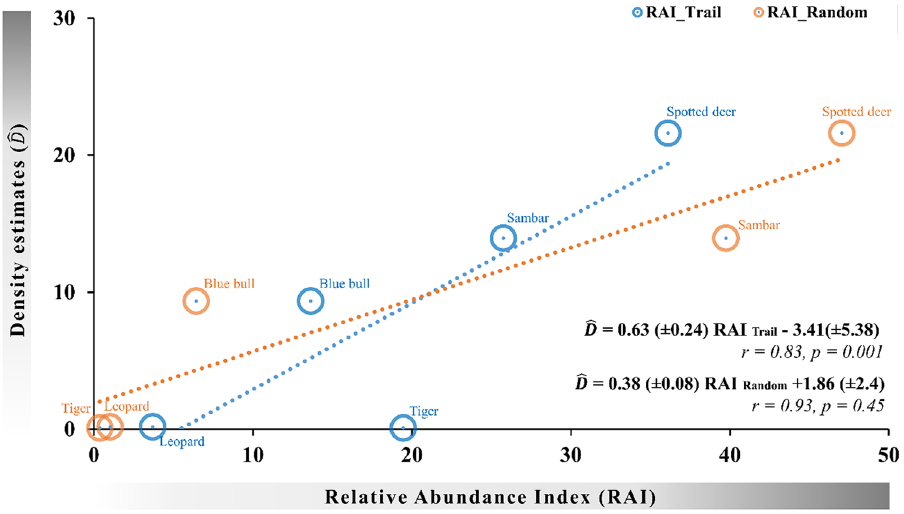
Figure 3. Scaling RAI values from different camera trap designs with absolute density. Only RAI’s from random camera trap placement designs had significant correlations with absolute